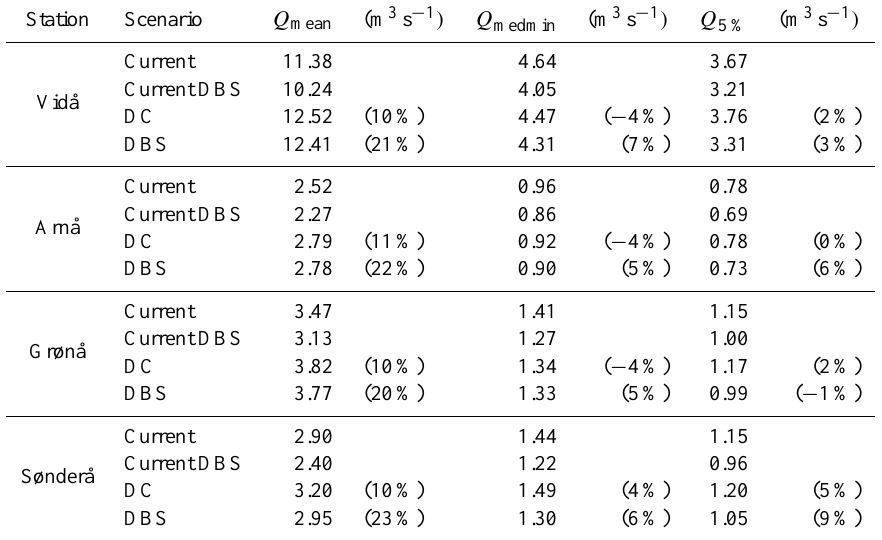
Table 6. Mean flow, median minimum flow and 5-percentile flow for the current climate and future climate according to the DC and DBS methods without irrigation in the model domain. Changes relative to the scenario representing current climate without irrigation are presented in parenthesis.